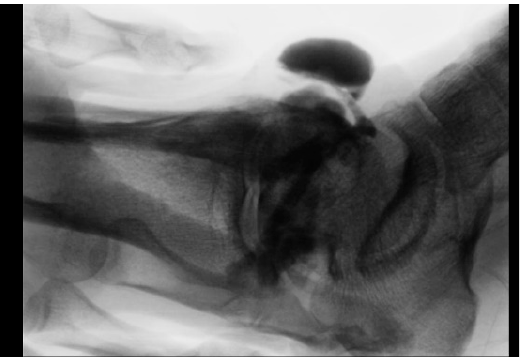
Figure 7. Arthrogram used to confirm fistulous communication between the joint and synovial